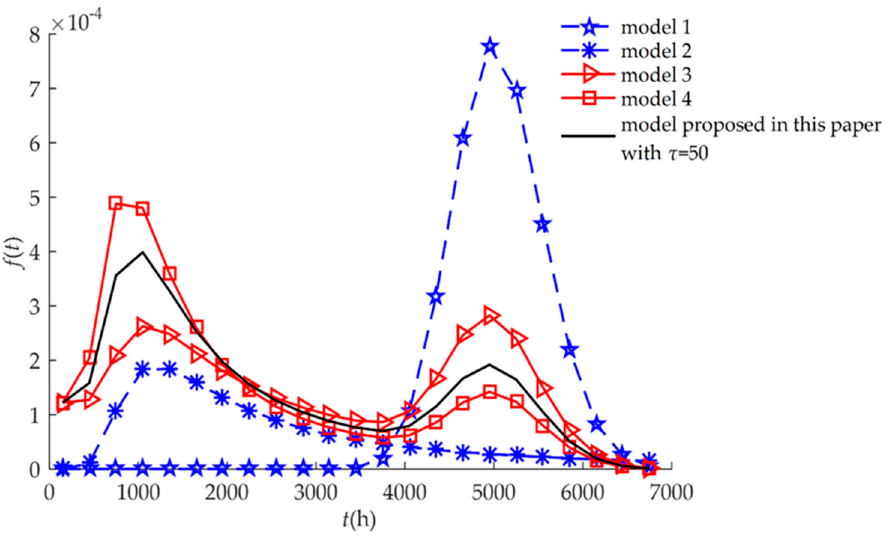
Figure 3. Comparison of f ( t ) for different models for example I.